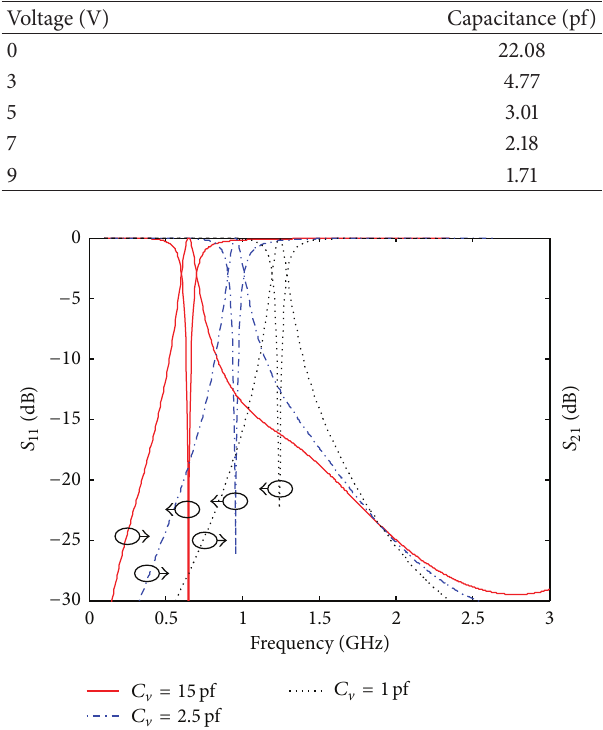
Table 2: Capacitance versus reverse voltage (MV31009).